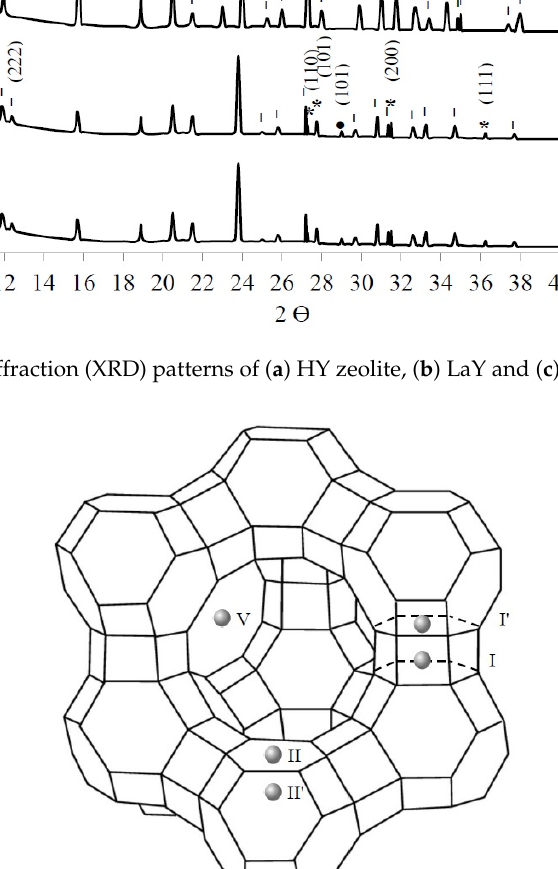
Figure 4. X-ray diffraction (XRD) patterns of ( a ) HY zeolite, ( b ) LaY and ( c ) Pd/LaY catalysts.